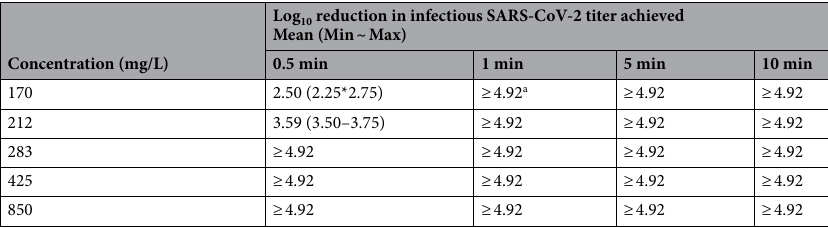
Log 10 reduction in infectious SARS-CoV-2 titer achieved Mean (Min ~